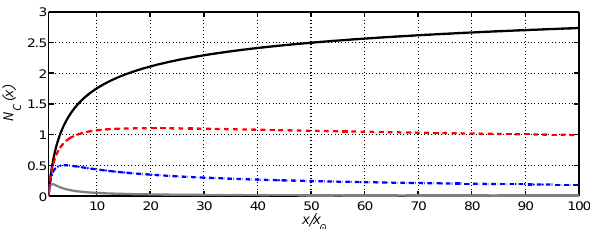
Fig. 11. Wave amplitude variations versus distance (Eq. 47) for γ =1 (black solid line), γ = 4 / 3 (red dashed line), γ = 2 (blue dash- dotted line), γ = 4 (green dotted line).